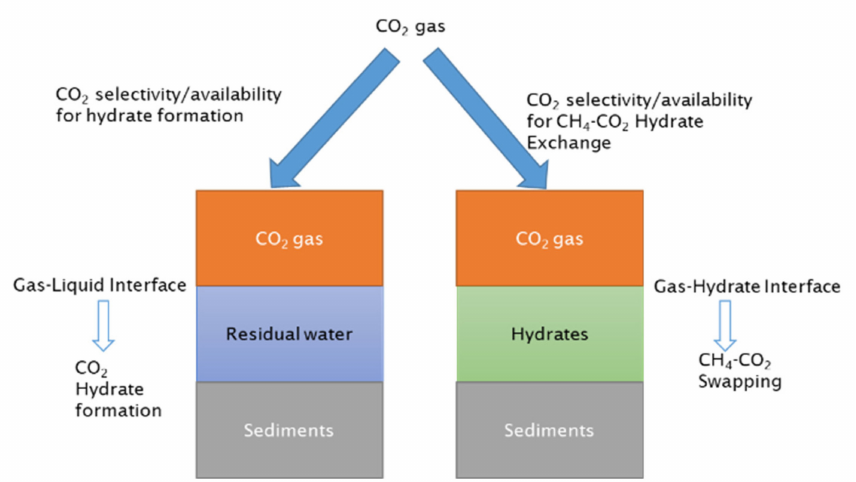
Figure 9. Conceptual layout showing key hydrate formation mechanisms during CO 2 injection into methane hydrate deposits and the role of residual pore water and methane hydrate